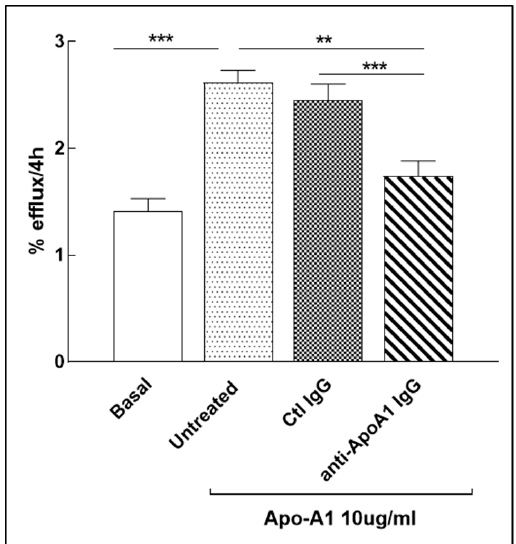
Figure 8. Anti-ApoA-1 IgGs inhibit passive diffusion. THP-1 cells were treated for 24 h with anti-ApoA-1 IgGs or ctl IgGs and passive diffusion was analyzed and expressed as percentage of the radioactivity released to the medium in 4 h over the total radioactivity incorporated by cells. p -values were calculated using the Student’s t -test: ** p = 0.010, *** p < 0.001.